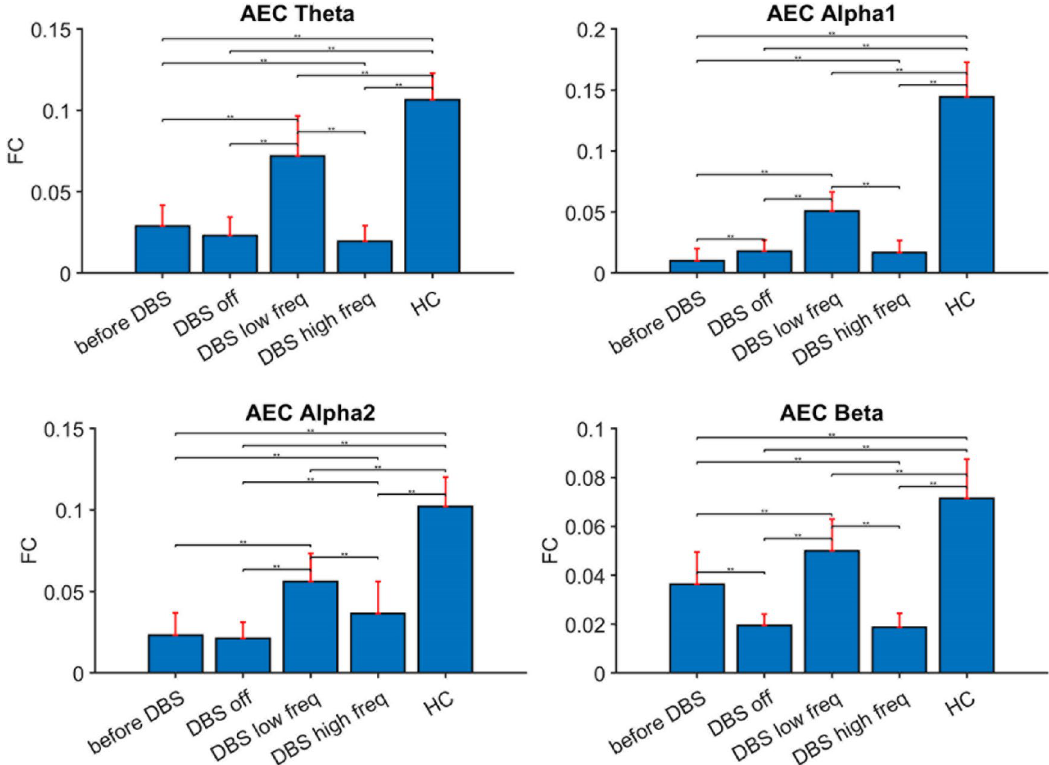
Figure 1. Functional connectivity (FC) in four different conditions in the patient, and for healthy controls (HC). Red bars: median values and interquartile range. Upper left: theta FC; upper right: alpha1 FC; lower left: alpha2 FC; lower right: beta FC. ** p < 0.01. AEC = AECc = corrected amplitude envelope correlation, before DBS = before implantation DBS, low freq = deep brain stimulation at 50 Hz/450 μsec, DBS high freq = deep brain stimulation at 130 Hz/60 μsec, DBS off = resting-state before